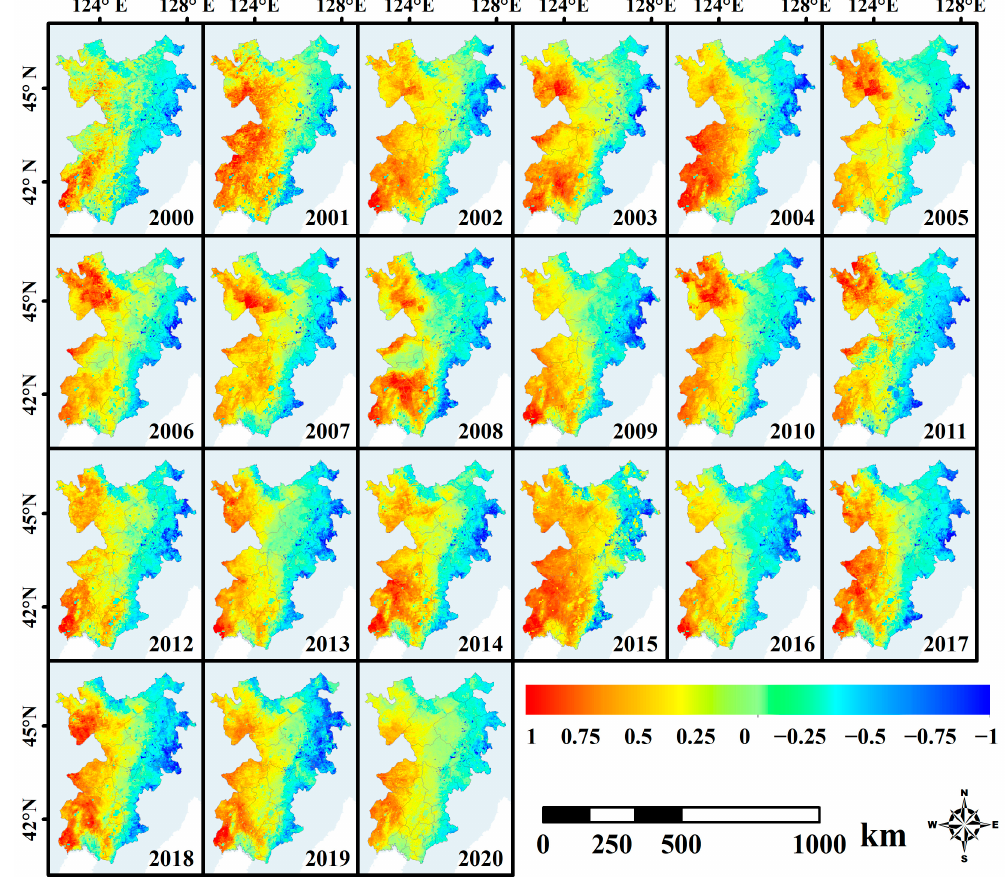
Figure 10. Spatiotemporal distributions of the drought and waterlogging hazards on maize in Songliao Plain for 2000–2020.